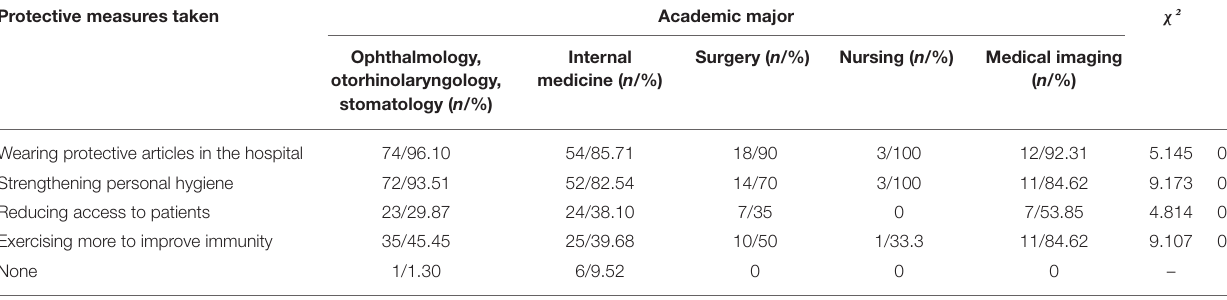
Wearing protective articles in the hospital